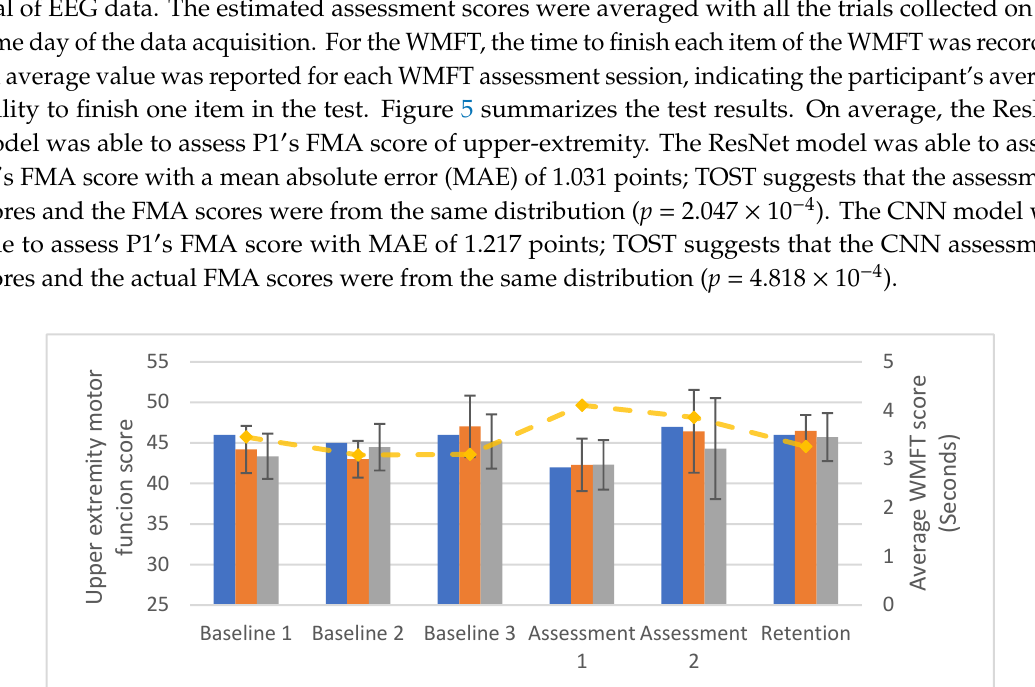
Figure 5. The longitudinal test results of the ANN models with EEG data collected from P1. Assessment scores from EEG data were produced based on single trials of EEG data and averaged across all EEG trials collected on the same day.